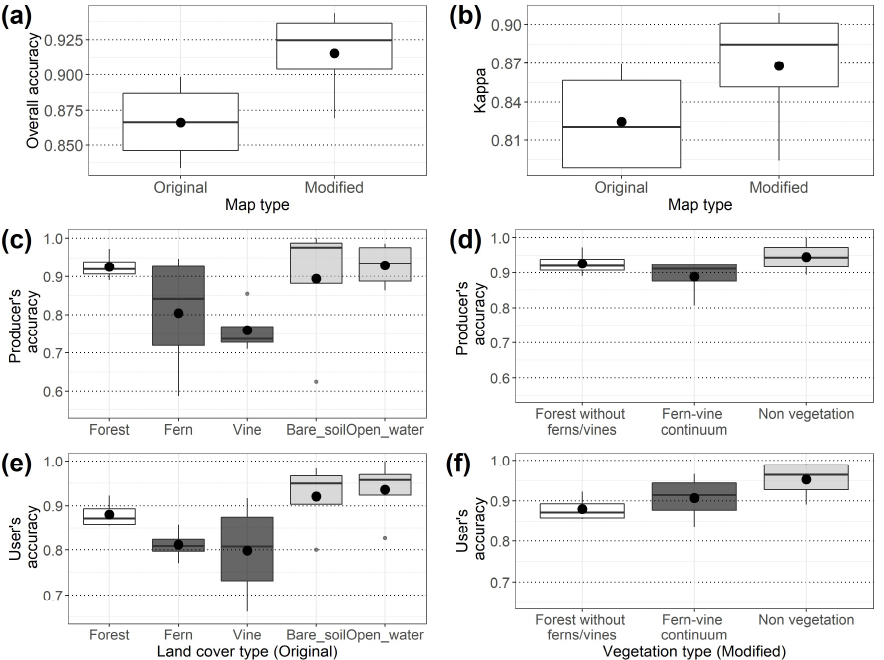
Figure 7. Classification accuracies for the obtained two vegetation maps; “original” indicates the originally developed map with five land-cover types depicted in Figure 6a, and “modified” indicates the modified map with three vegetation types depicted in Figure 6b. ( a ) The overall accuracy and ( b ) Kappa coefficient of each map, ( c ) the producer’s and ( e ) user’s accuracies of the original vegetation map, and ( d ) the producer’s and ( f ) user’s accuracies of the reclassified modified map. Dots represent the mean value of each metric.